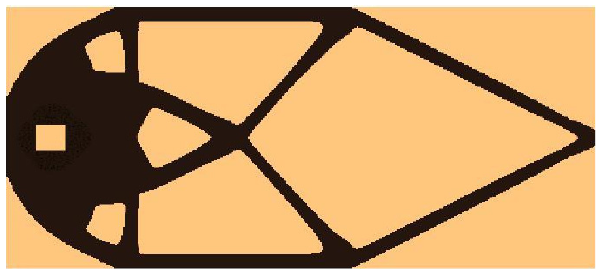
Figure 16. The final topology found for the test structure 3.